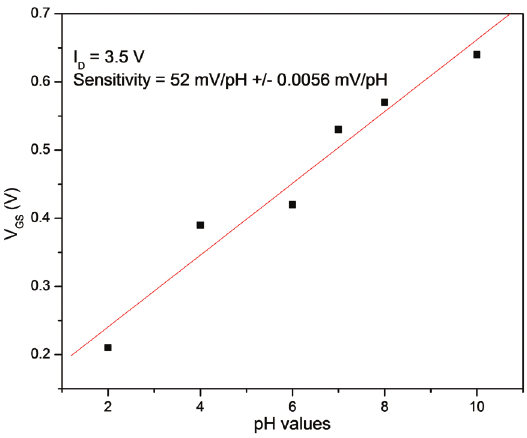
EGFET pH sensor for buffer 3